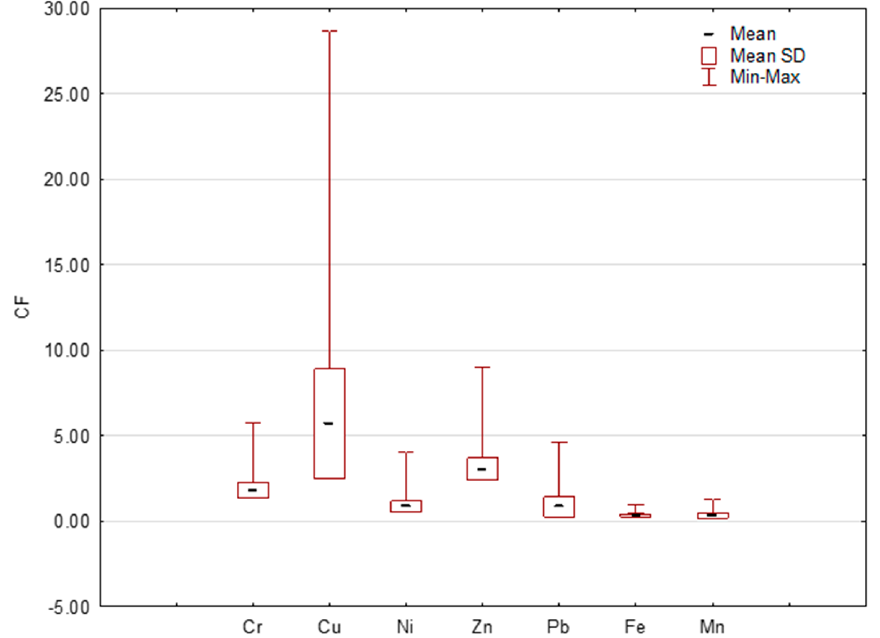
Figure 4. Assessment of level of pollution by contamination factor (CF).